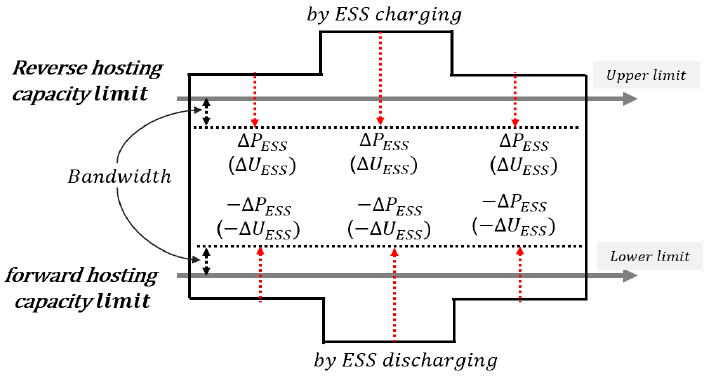
Figure 5. Margin (Bandwidth) considering PCR.